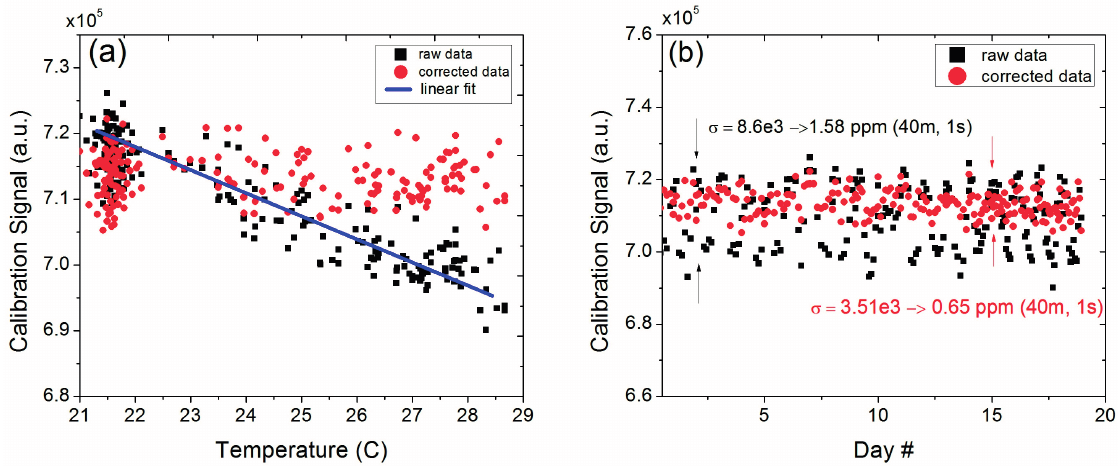
Figure 6. ( a ) Temperature dependence of the calibration signal as a result of larger temperature swings within the weatherized enclosure and the data corrected with by the temperature-dependent spectral model; ( b ) Calibration signals over the course of 19 days before and after temperature